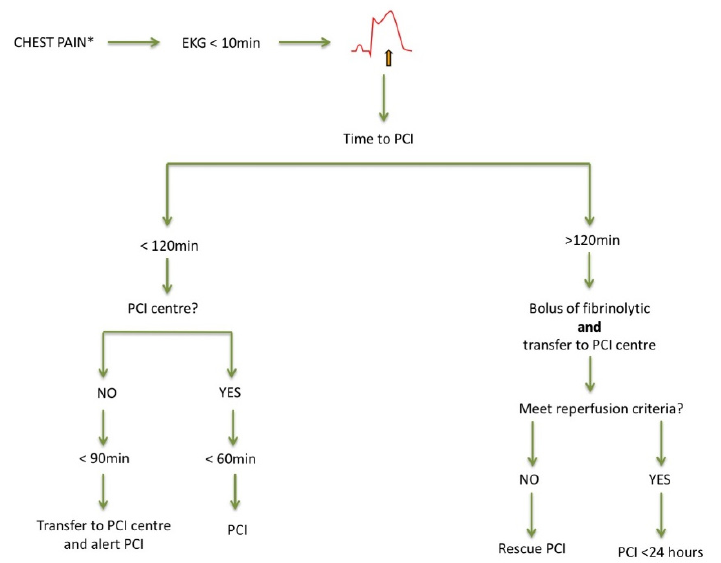
Figure 1. Management of acute ST-segment elevation myocardial infarction. Adapted from [16]. EKG: electrocardiogram; PCI: percutaneous coronary intervention. * Atypical presentation is common.